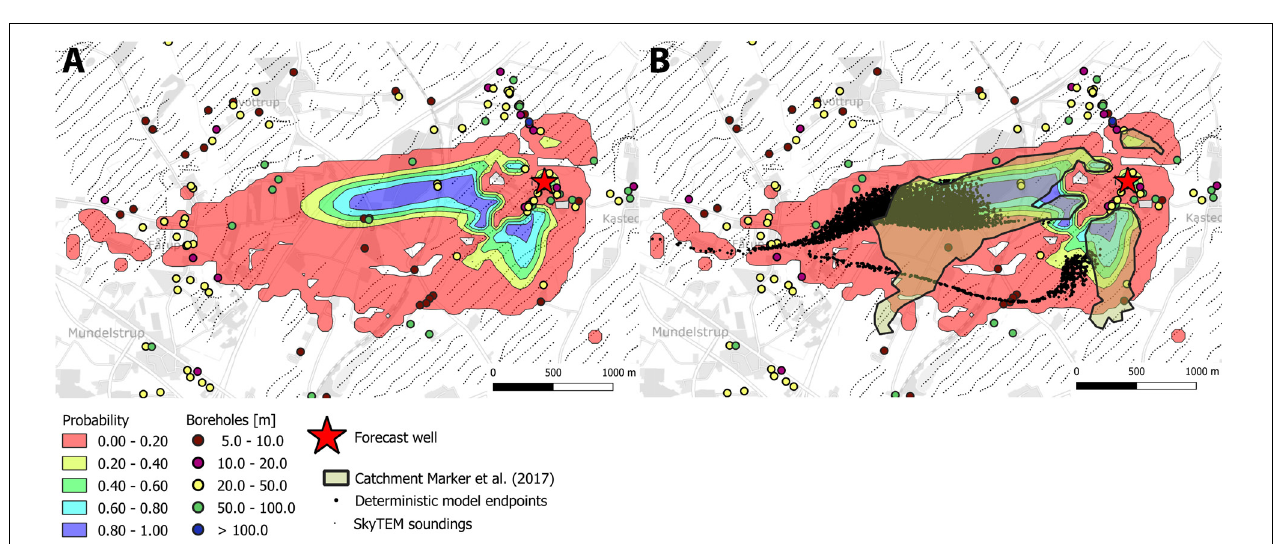
FIGURE 11 | Probability plots of well catchment zones for the Kasted well estimated from the 4-cluster model realizations. (A) Catchment probability (B) Probability map overlaid with catchment from deterministic model and outline from Marker et al.